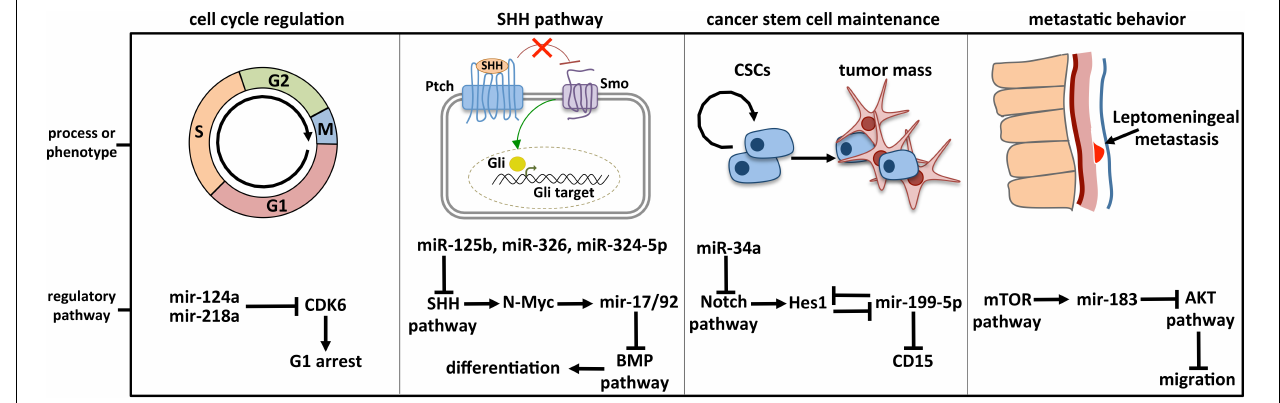
FIGURE 3 | Deeply characterized cellular processes affected by miRNAs in MB. The brain-enriched miR-124a and miR-218a participate in cell cycle control by modulating the expression of CDK6, the cyclin-dependent kinase 6 crucially implicated in cell cycle progression. MiR-125b, miR-326, miR-324-5p, and MiR-17/92 cluster is included in the regulatory axis between the SHH and the BMP signaling, participating in the cell choice between proliferation and differentiation. MiR-125b, miR-326, and miR-324-5p guide the SHH pathway, modulating Smo and Gli1, respectively activator and effector of the cascade. MiR-199-5p is involved in CSC maintenance by modulating the CSC marker CD15 and Hes1, the main Notch downstream effector with which a negative regulative feedback loop is established. Notch signaling is also controlled by miR-34a, at the level of the ligand Dll1. The retinal miR-183 is part of the regulative axis between mTOR pathway, from which it is activated, and AKT pathway involved in cell